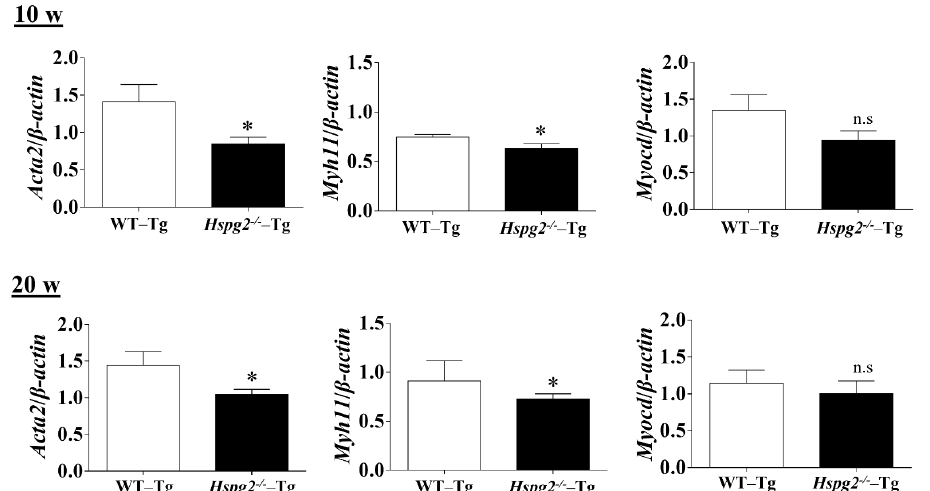
Figure 5. qPCR analysis of SMC-specific markers in the aortic tissue of Hspg2 − / − -Tg mice without AD at 10- and 20-weeks of age. RNA expression of SMC-specific marker genes, Acta2 and Myh11 , was significantly decreased in Hspg2 − / − -Tg mice. Myocardin ( Myocd ) expression in Hspg2 − / − -Tg mice was not significantly different from that in WT-Tg mice. RNA expression levels were normalized to that of β -actin and are indicated relative to the latter. (Mean ± SEM, n = 5, * p < 0.05 vs.